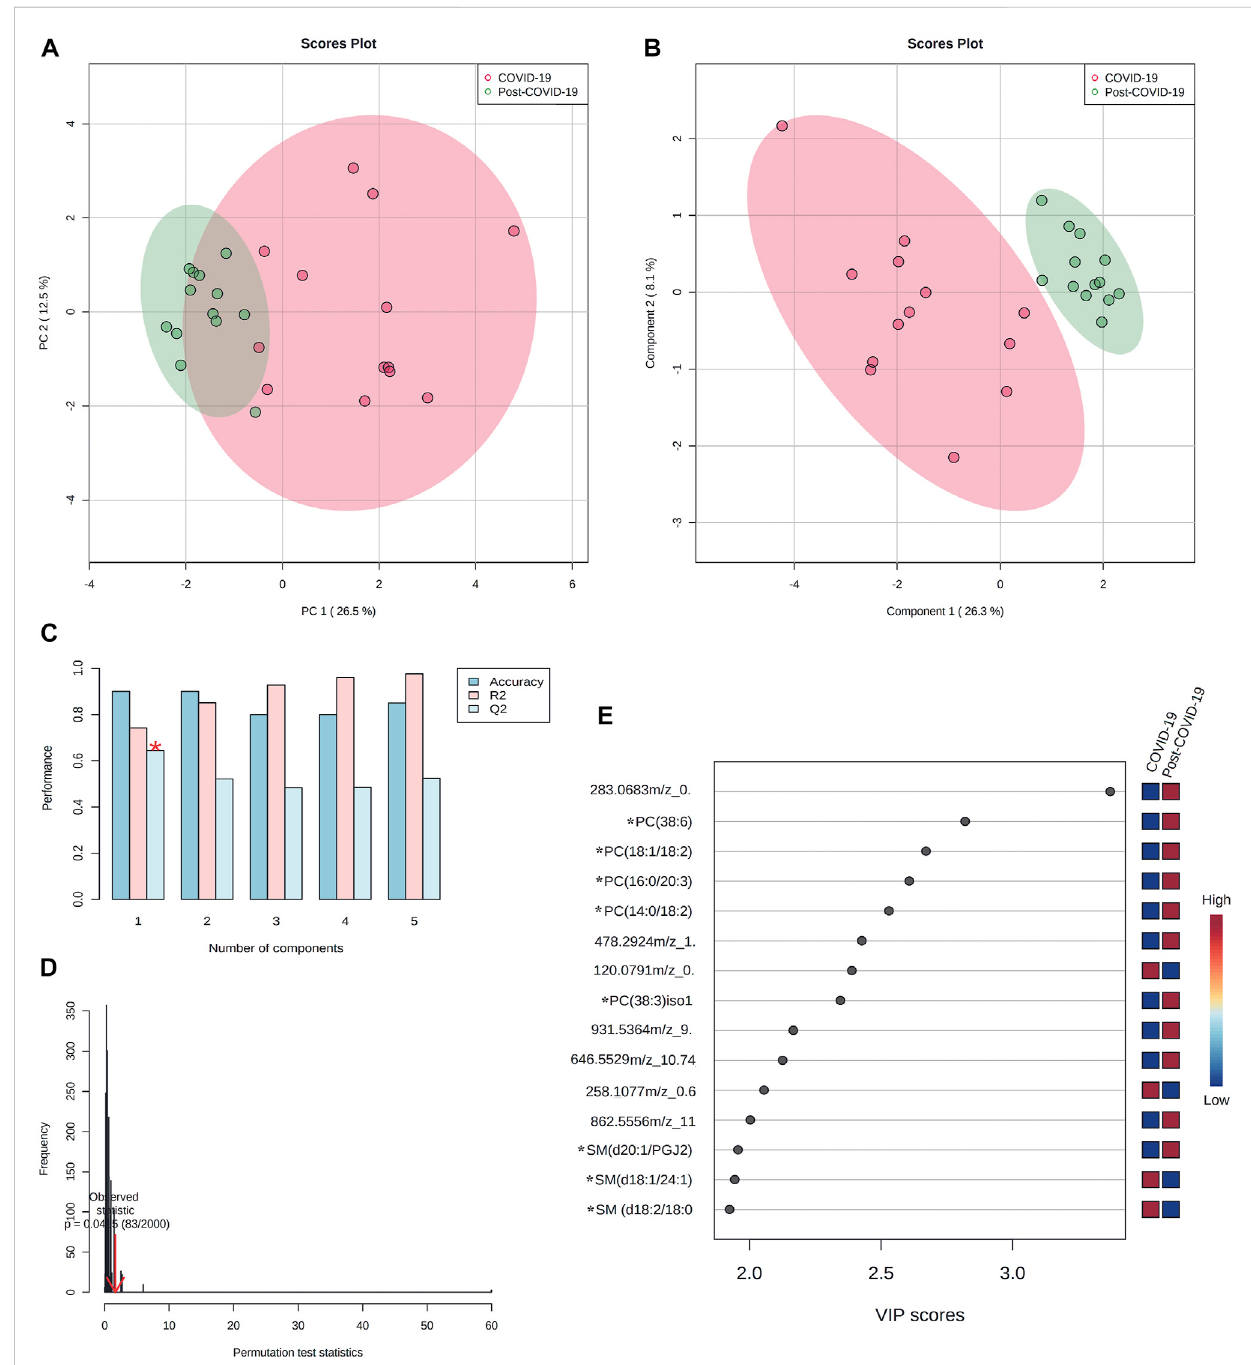
FIGURE 8 Multivariate paired analyses from plasma lipidomics pro fi le of COVID-19, and post-COVID-19 patients. (A) Score scatter plot based on PCA models including paired samples. (B) Score scatter plot based on PLS-DA models. (C) Cross validation (10-foldCV). (D) permutation test (2000 permutations). (E) Variable importance in Projection (VIP) plot representing the rank of 15 features identi fi ed by PLS-DA according to VIP score on x -axis. The most discriminating metabolites areshownindescendingscoreorder.Thecolorboxesindicatewhethermetaboliteconcentrationwasincreased(red)or decreased (blue). * Represents features with con fi dence level 2. Figures were produced in MetaboAnalyst software v 5.0 (https://www.metaboanalyst.